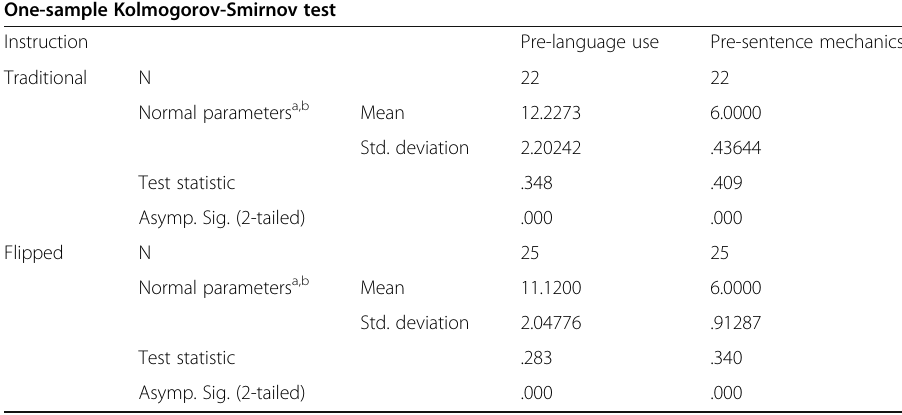
Table 9 Test of normality (pre-language use and pre-sentence mechanics) One-sample Kolmogorov-Smirnov test